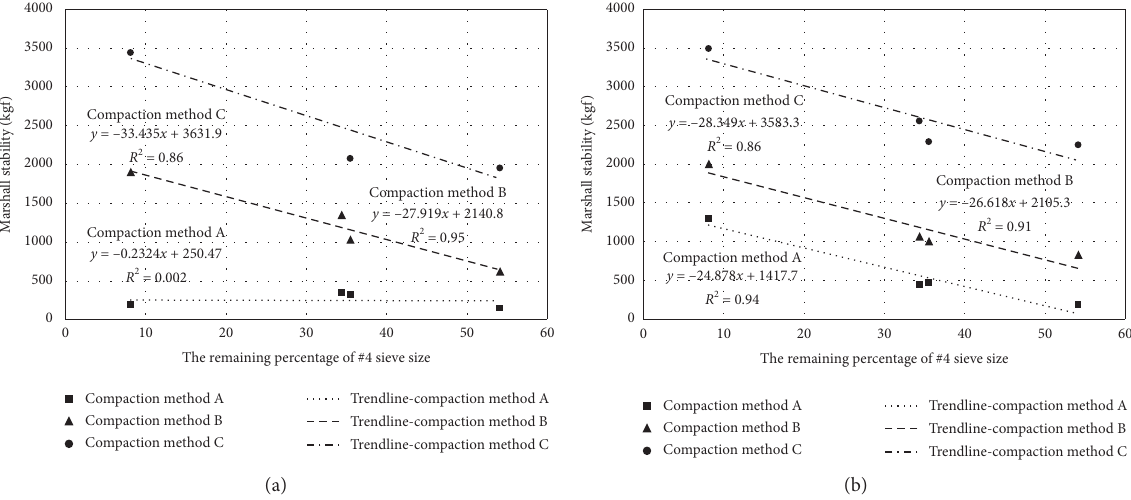
Figure 4: Correlation between Marshall stability and proportion of coarse aggregate indicating (a) short- and (b) long-term performance.